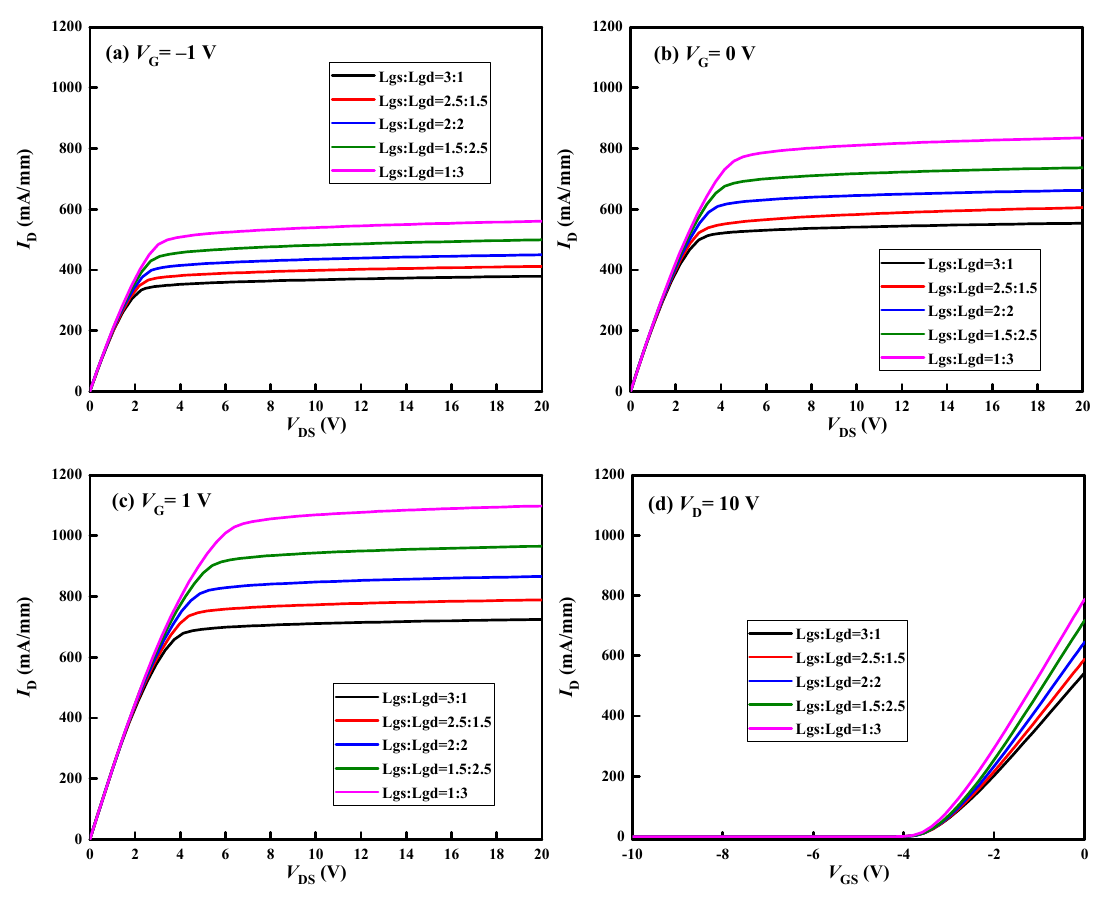
Figure 10. The output and transfer characteristics of the GaN HEMT for different device structures: ( a ) I D - V DS at V G = − 1 V; ( b ) I D - V DS at V G = 0 V; ( c ) I D - V DS at V G = 1 V; ( d ) I D - V GS at V D = 10 V.